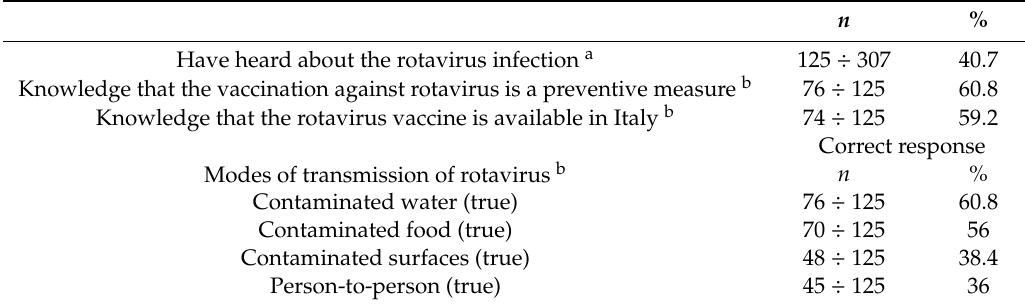
Table 2. Knowledge about rotavirus infection of the study respondents.